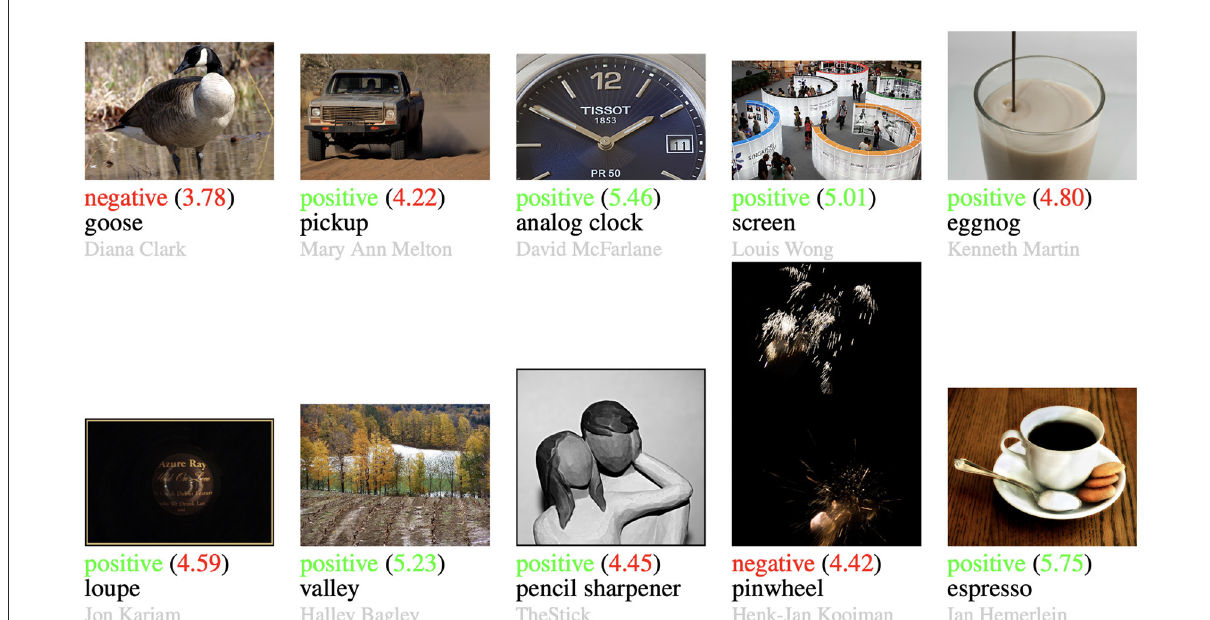
FIGURE2 Example images with the binary prediction by the context-aware prompts for CLIP, the actual score by AVA (in parenthesis), and the content of the prompt with the highest similarity to the image. The predictions and actual scores are colored to easily find the predictions that are correct or wrong. Image credit is given in gray (name or username of photographer on